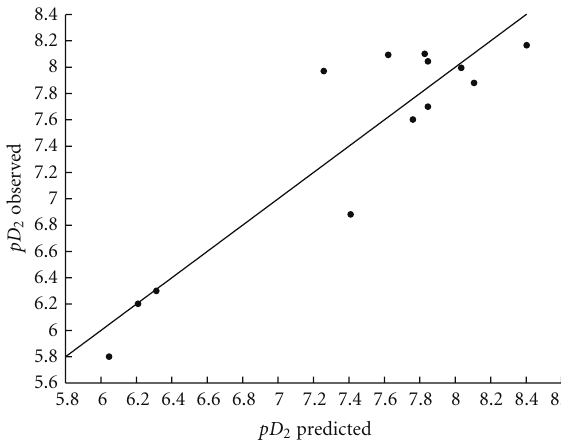
Figure 2: Observed versus predicted values of agonistic activity p D 2 according to (6).